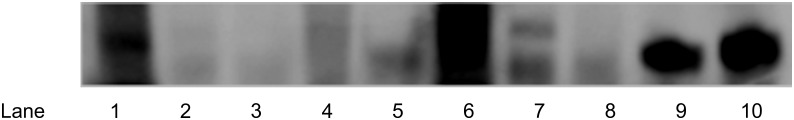
Southern blot for 40 nt sequences.The complementary sequence is labelled with a marker. This marker enables detection of the hybridized sequence through X-ray radiography. Lanes 1, 2 and 3, unpurified MEA 40 nt product in three different amounts (20, 10, 5 uL), lane 4 and 5, the ssDNA product from modified isothermal amplification method with a single primer. Lane 6–8, purified MEA products. Lanes 9–10, reference ssDNA sequences of 40 nt length, of oligonucleotide composition as the intended 40 nt sequence.